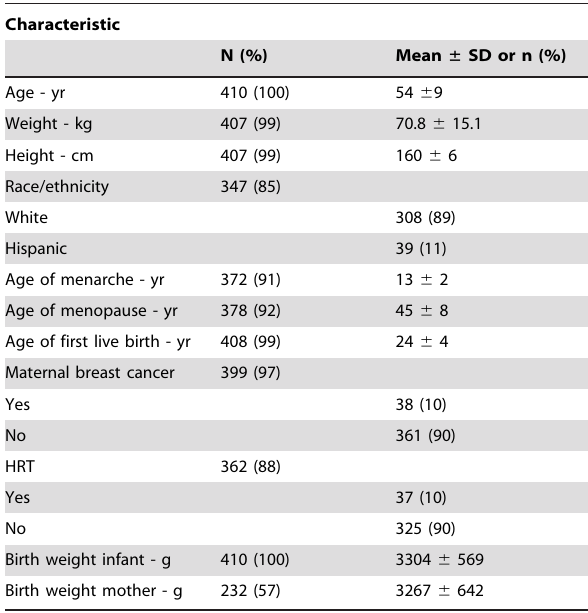
Table 1. Baseline Characteristics of the Framingham Offspring Birth History Study